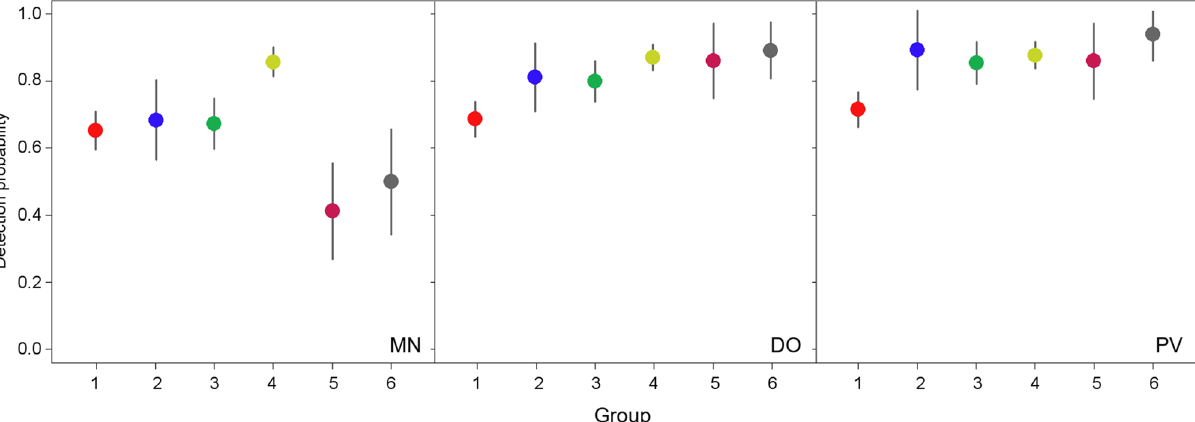
Figure 5. Bird species detectability at group level for each of the three methods deployed in pond surveys in south-eastern Spain. Method-specific, model-averaged estimates of detection probabilities (independent of the survey time) grouped by species group. Vertical lines represent 95% confidence intervals. Numbers refer to six different established groups based on body size and main diet type: (1) small insectivorous (< 30 g); (2) medium- sized and large insectivorous (≥ 30 g); (3) small insectivorous and frugivorous (< 30 g); (4) small seed-eaters (< 30 g); (5) medium-sized and large seed-eaters (≥ 30 g); and (6) medium-sized and large generalists (≥ 30 g). Sampling method label appears in the bottom right corner as follows: MN mist netting, DO direct observation, and PV direct observation plus video monitoring. The figure was created in R (version 4.0.2, https ://www.R- proje ct.org/) and assembled with GIMP (version 2.10.14, https